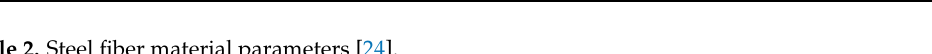
Table 2. Steel fiber material parameters